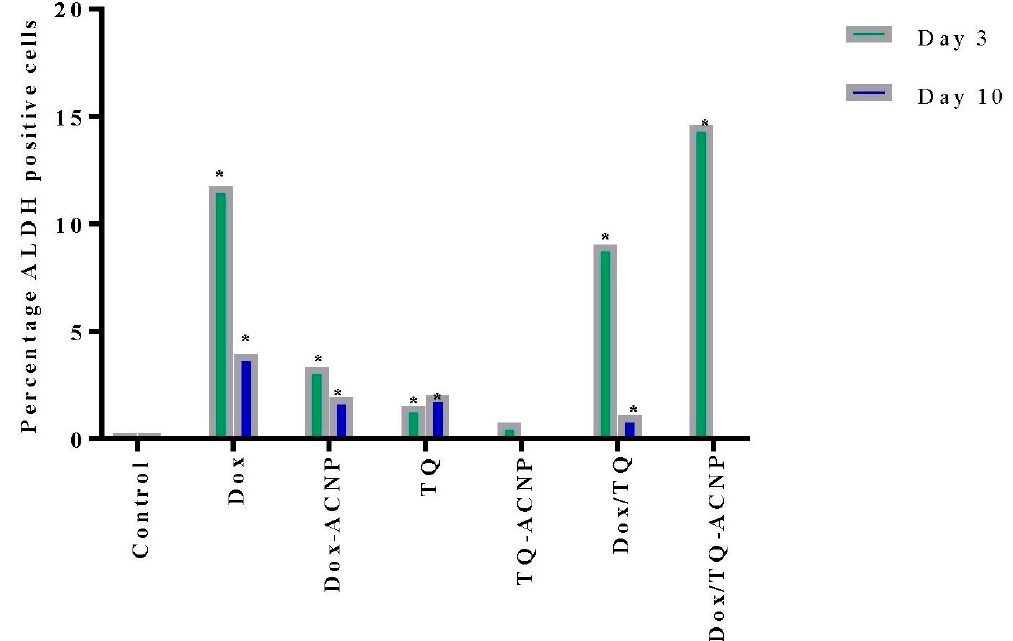
Figure 14. Graphical representation of ADLH activity after treatment at days 3 and 10. * p < 0.05 compared to